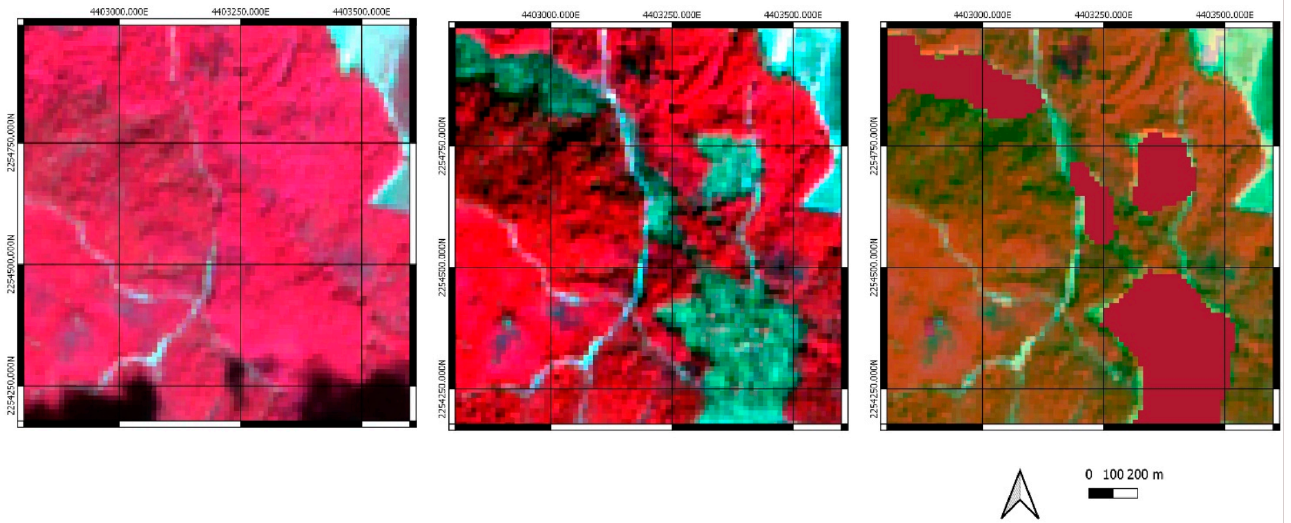
Figure 12. Other disturbances—Forest harvesting, highlighted in red on the right